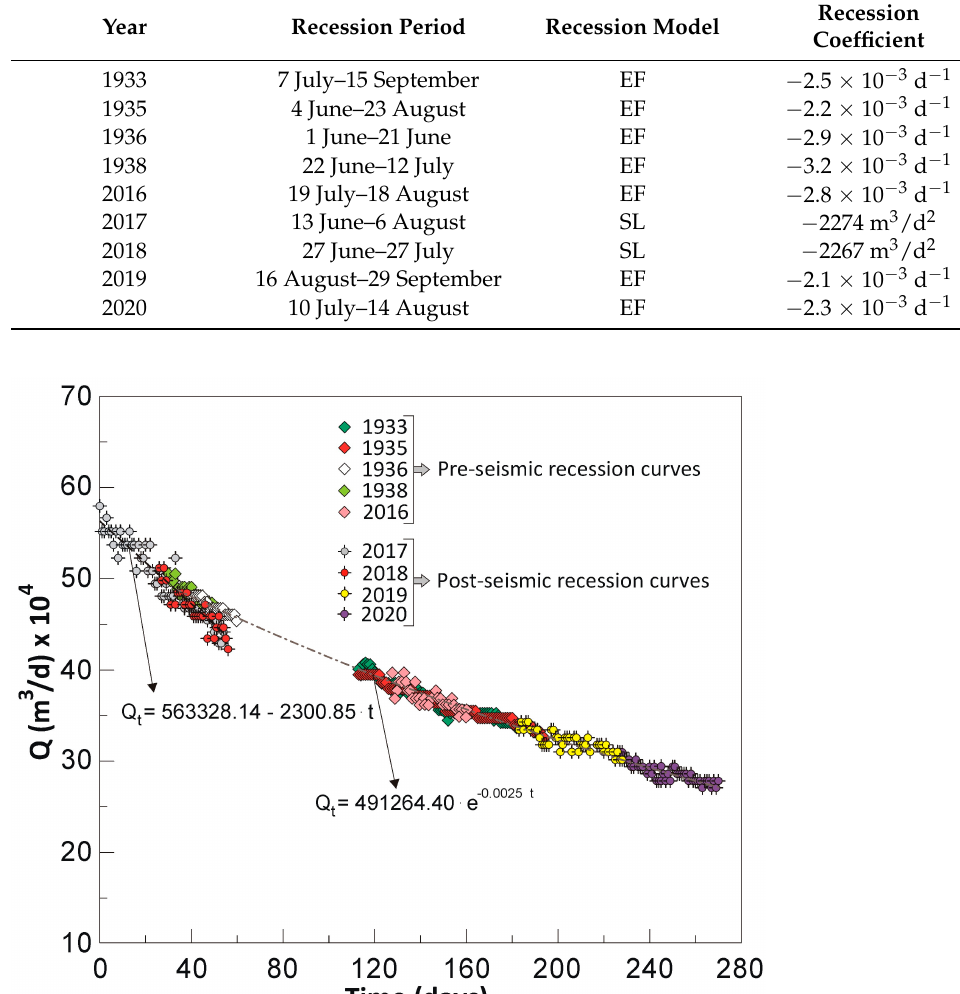
Figure 7. Pre- and post-seismic recession curves for the Nera River at section I1. Discharge data are in the supplementary materials (Table